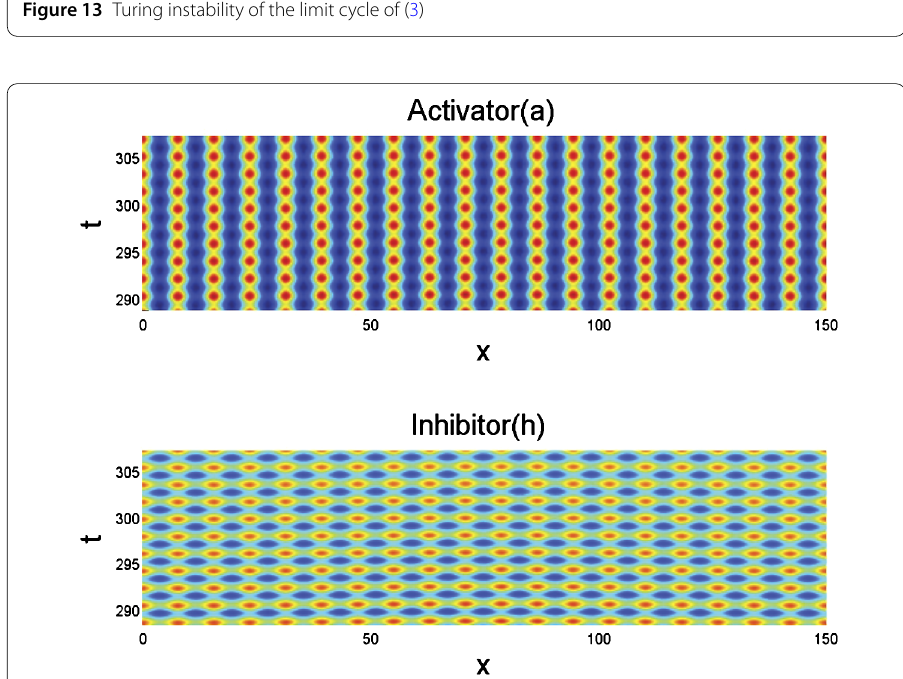
Figure 14 The local enlargement of the projection of Fig. 13 in ( x , t ) coordinates for (290 < t < 305)